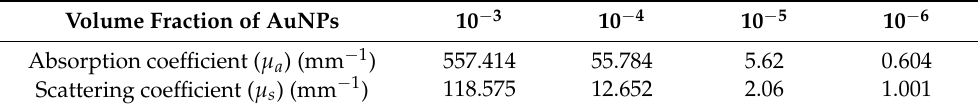
Table 4. Optical properties of the tumor tissue with different volume fractions of